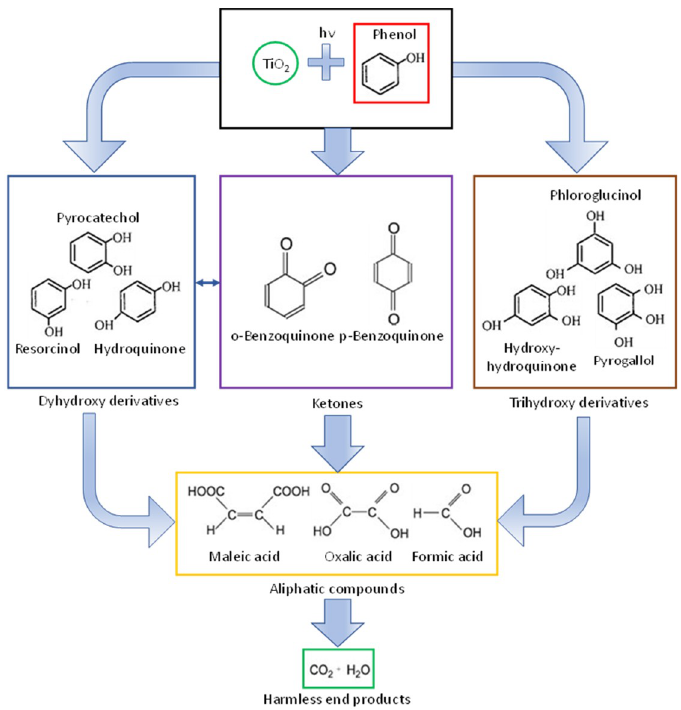
Figure 1. Possible intermediates of phenol during its photocatalytic oxidation [46–48].